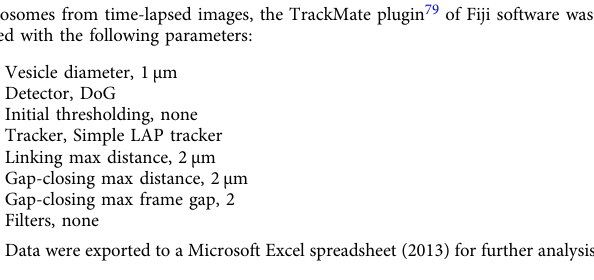
Fig. 7 RUFY3 depletion reduces lysosome size. a pH calibration curve based on ratiometric fl uorescence intensity measurements of Lysosensor Yellow/ Blue DND-160. b Graph showing average pH value of lysosomes measured from HeLa cells treated with the indicated siRNAs. Values plotted are the mean ± SD from six independent experiments (n.s. not signi fi cant; two-tailed Student ’ s t -test). c , d Representative histogram showing mean fl uorescence intensity (MFI) of Lysotracker Red DND-99 (LTR) uptake (1 h) in control siRNA- and RUFY3 siRNA-treated HeLa cells ( c ), and the graph in d represents the relative percentage of MFI for LTR uptake from three independent experiments (**** p < 0.0001; two-tailed Student ’ s t -test). e , f Representative micrographs of live HeLa cells treated with the indicated siRNAs and labeled with LTR. The asterisk indicates cells transfected with the GFP-RUFY3 siRNA- resistant plasmid. Scale Bars: 10 µ m. The quanti fi cation of the average fl uorescence intensity of LTR-positive vesicles is shown in f . The values plotted are the mean ± SD from three independent experiments. Experiments are color-coded, and the total number of cells analyzed is indicated on the graph (**** p < 0.0001; two-tailed Student ’ s t -test). g – j Represen t ative TEM images of HeLa cells treated with the indicated siRNAs. Higher magni fi cations of lysosomes (dense and multi-lamellar structures, indicated by yellow arrowheads) are shown in the right panels. Scale Bars: 2 µ m (main); 0.5 µ m (inset). Lysosome size ( i ) and number ( j ) were quanti fi ed using TEM images. Note: in i , n represents the number of lysosomes analyzed for size measurement. k – n Representative SIM images of HeLa cells treated with indicated siRNAs and stained with anti-LAMP1 antibodies. Insets represent a magni fi ed view of boxed areas, highlighting differences in lysosome size. The average area ( m ) and count ( n ) of LAMP1-positive vesicles per cell was measured in HeLa cells upon treatment with the indicated siRNAs. o – r Representative SIM images of HeLa cells treated with the indicated siRNAs and stained with anti-LAMP1 antibody. In the insets, zoomed views of selected ROIs are shown, and quanti fi cation of the average area of lysosomes is plotted ( r ). The values plotted are the mean ± SD and the total number of cells analyzed are indicated on the graph (**** p < 0.0001; *** p = 0.0006; two-tailed Student ’ s t -test). Scale Bars: 10 µ m (main); 1 µ m